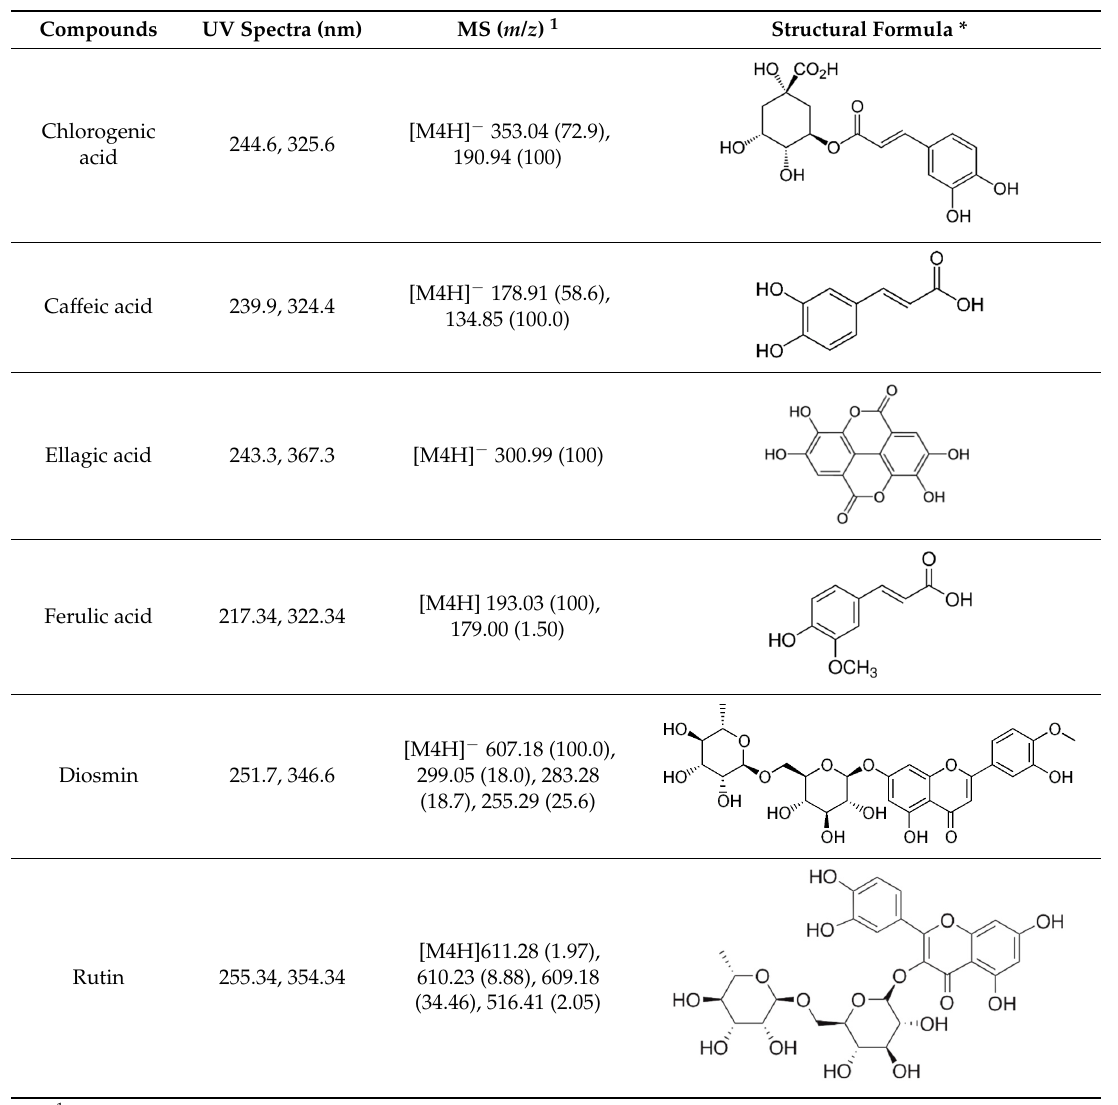
Table 3. Mass spectrometer (MS) parameters of phenolic compounds.